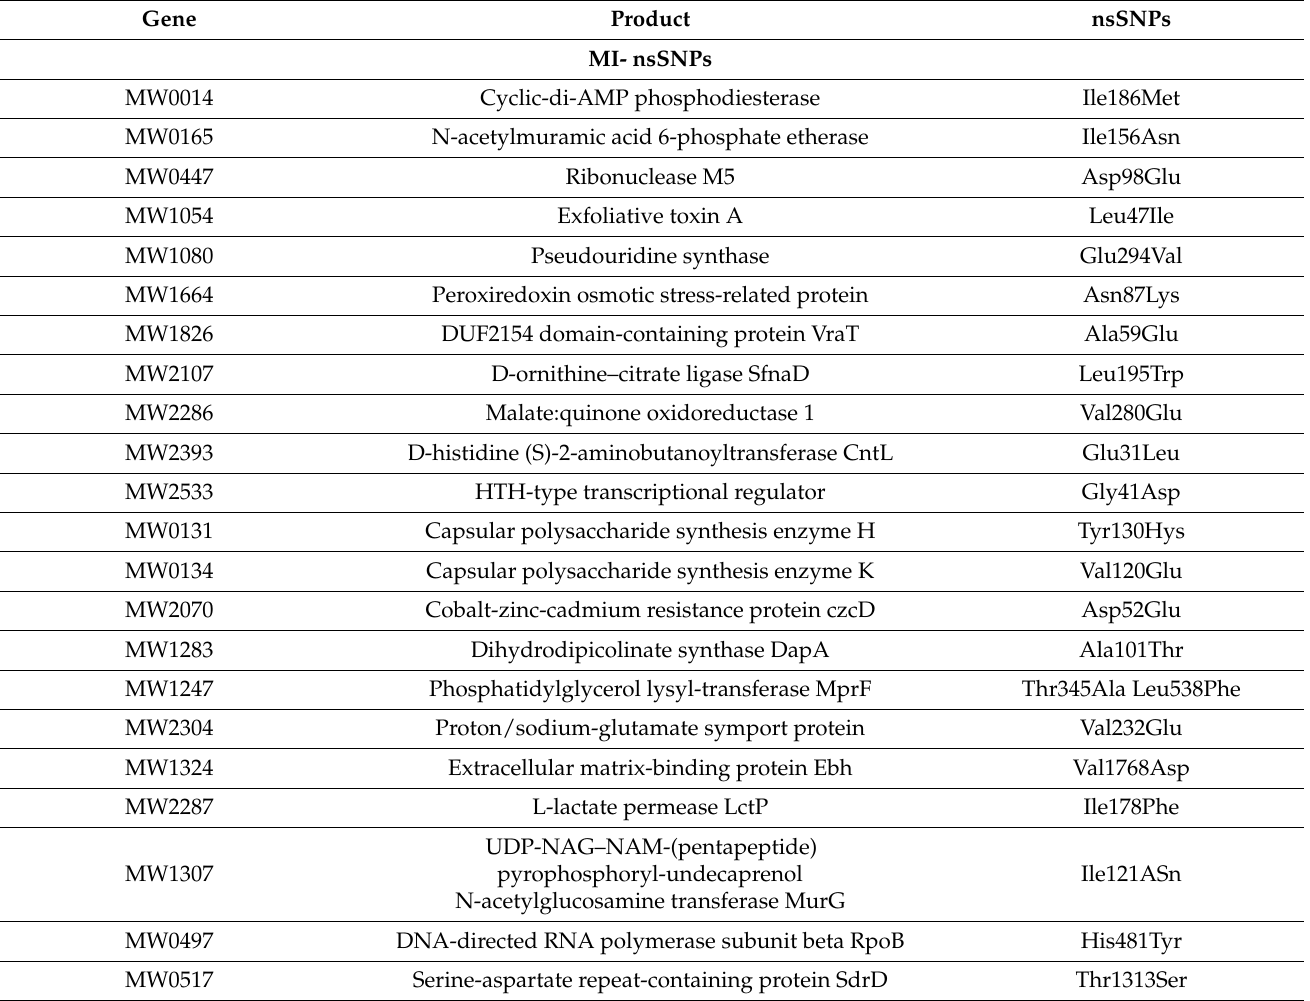
Table 5. MI nsSNPs in 1-R vs. 1-S on MW2 CA-MRSA RefGen